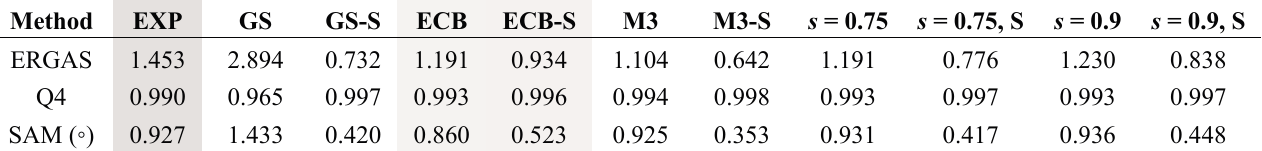
Table 9. Quantitative comparison of the fusion results after degrading the images into the LR resolution, i.e ., at 2.0 m, to check the consistency property of the Wald’s protocol for the WorldView-2 group 1 dataset at full scale.